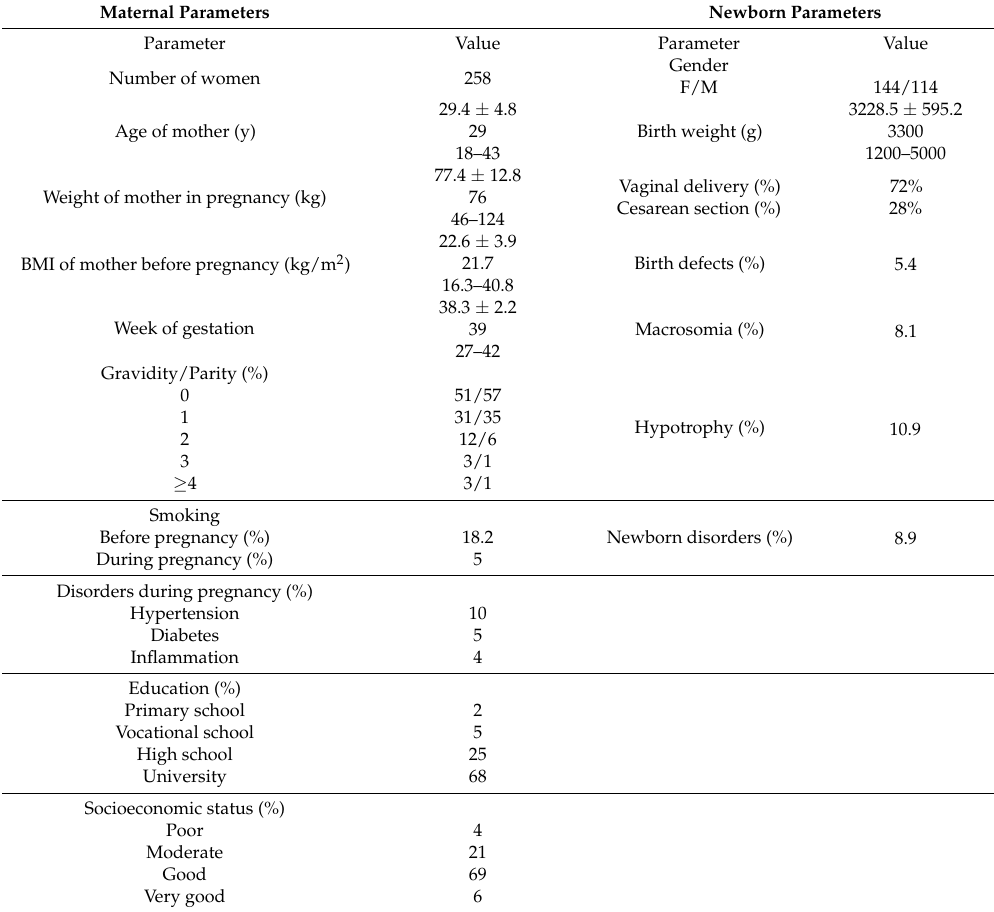
Table 1. Characteristics of the total population (mean ±